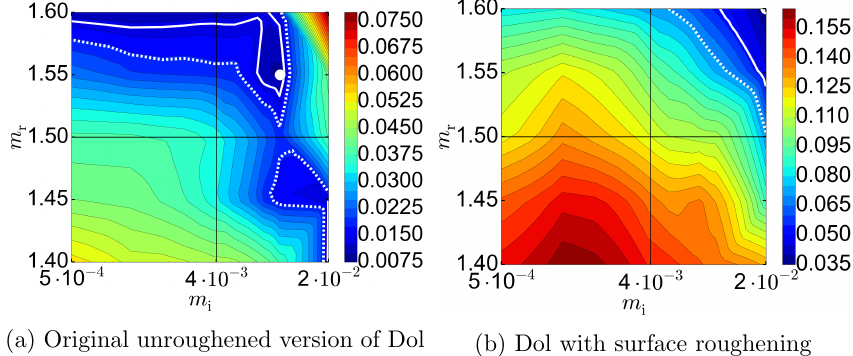
Figure 5. Illustration of the effect of roughening on P 34 of Dol as in Fig. 3. The added modest surface roughness in (b) changes the behavior of the scattering error as function of the refractive index dramatically.